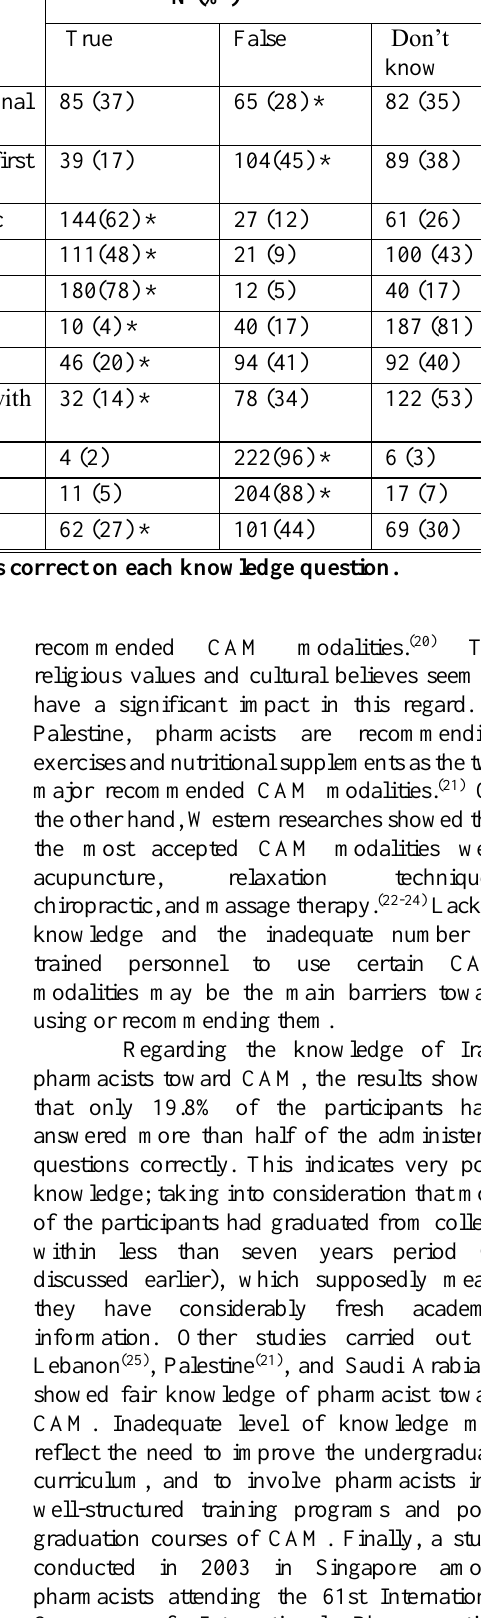
Table 3. Pharmacists’ responses on knowledge-based items about different CAM uses